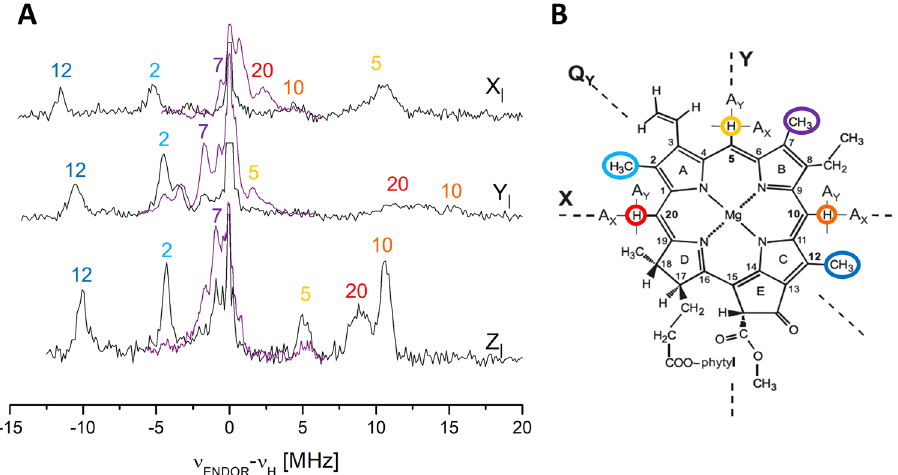
Figure 3. ( A ) X-band Pulse ENDOR spectra of WSCP 3 Chl a for the X I , Y I and Z I EPR field positions (363.0 mT, 356.1 mT and 315.3 mT, respectively). Davies (black) and Mims (purple) spectra. Temperature 20 K. The frequency scale gives the deviation from ν H . The intense central ν H lines in the Davies spectra have been cropped for better comparison. The assignments are labeled according to numbering and color code reported in panel B . ( B ) Scheme of Chl a structure with the orientation of the ZFS axes ( Z not shown, perpendicular to the molecular plane). The protons corresponding to the ENDOR peaks in panel A are highlighted by circles.